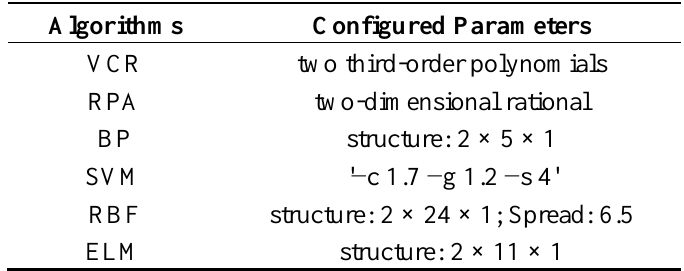
Table 5. Configured parameters of algorithms using 4 × 6 calibration.